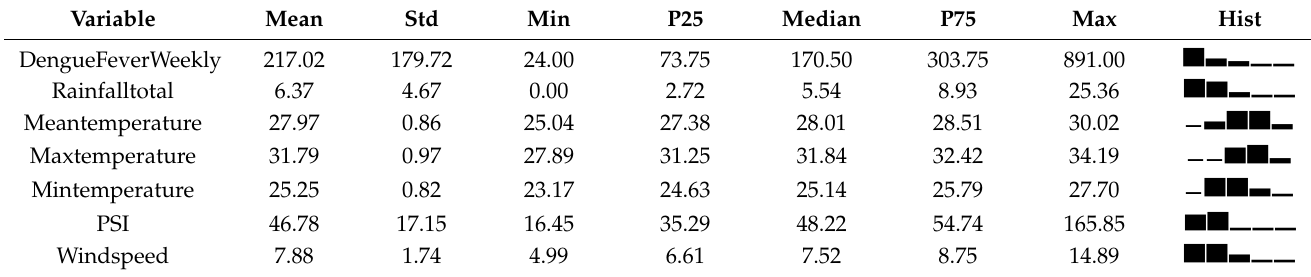
Table 1. Descriptive summary of weekly dengue cases and weather conditions in Singapore during 2012–2019.